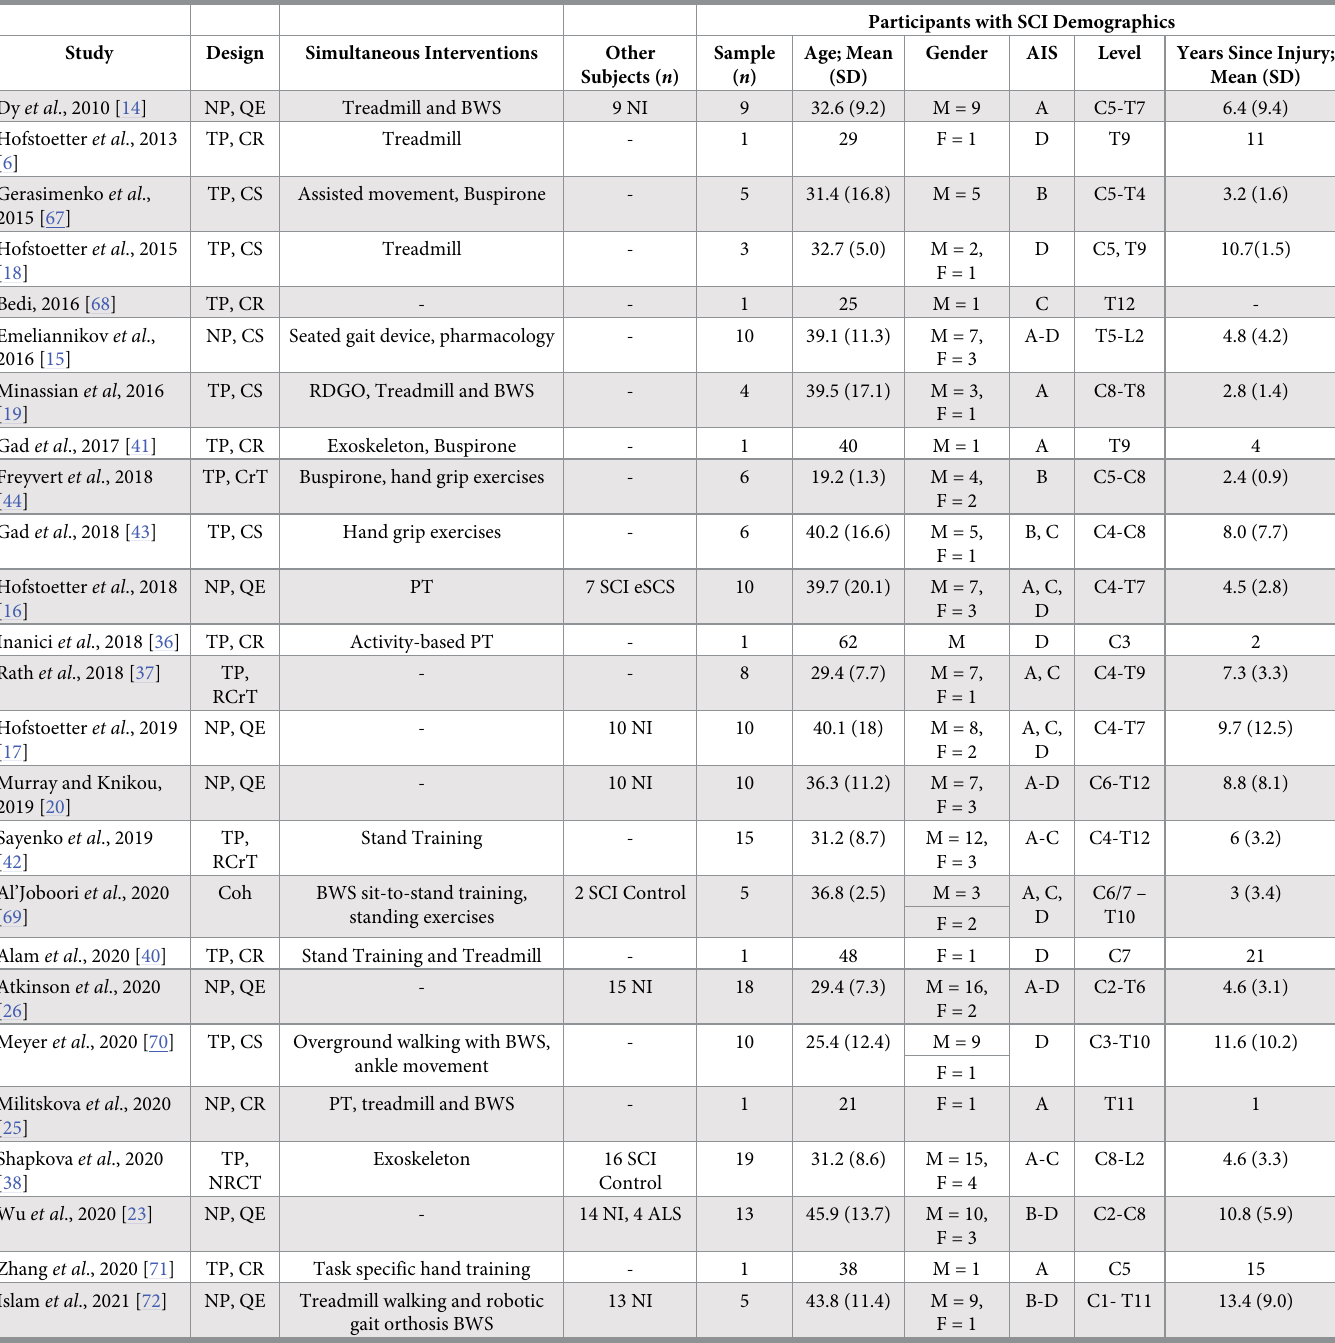
Table 3. Details of study characteristics and the demographics of included participants. Study characteristics and participant